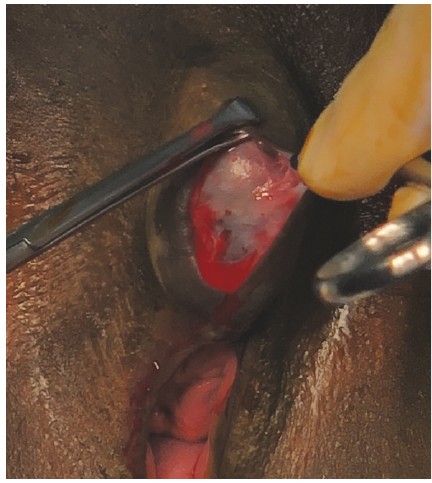
Figure 1: Preoperative view of the clitoral neuroma. Figure 2: Cystic appearance of the neuroma.